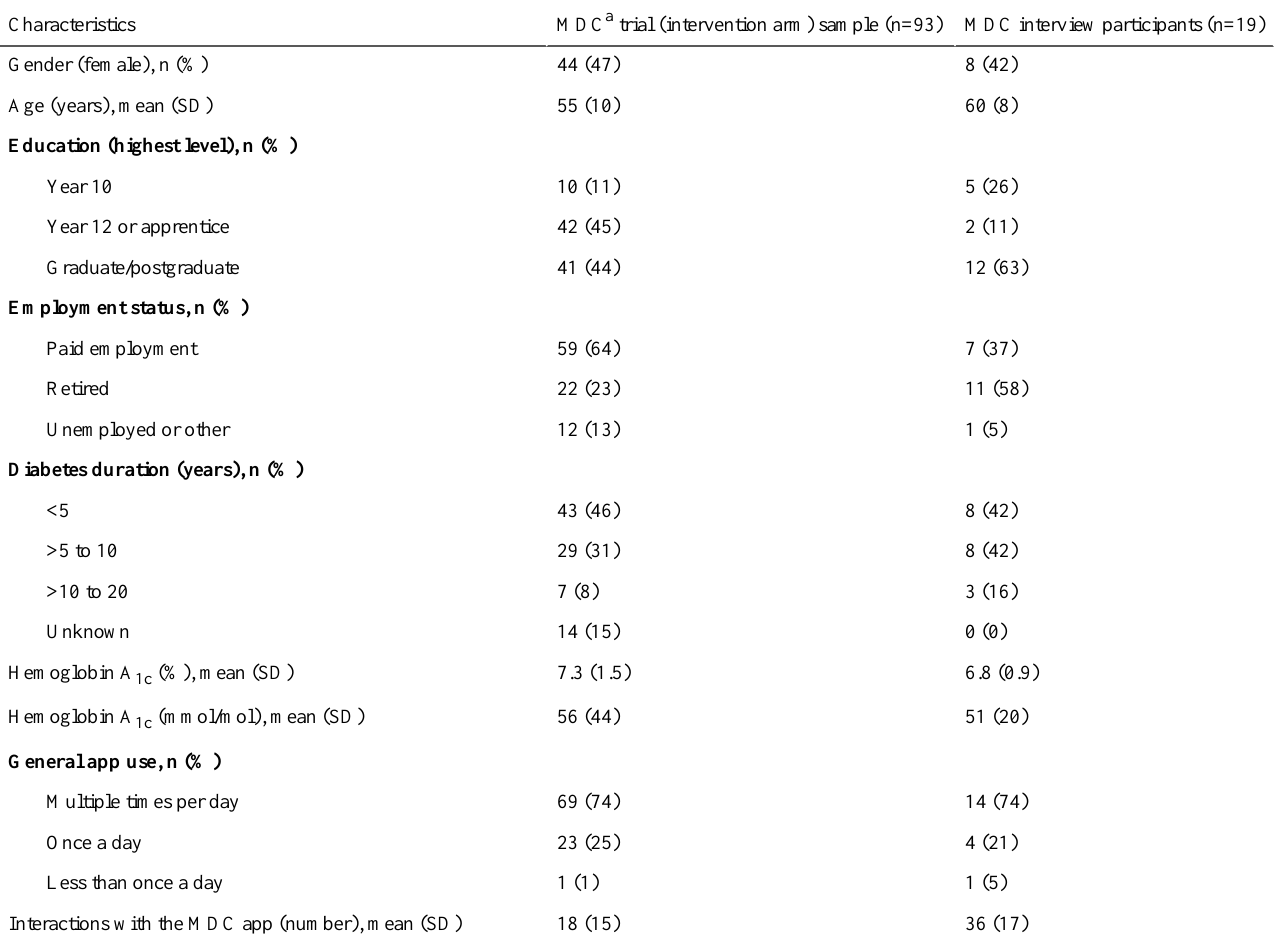
Table 1. Participants’demographic and clinical characteristics and current app